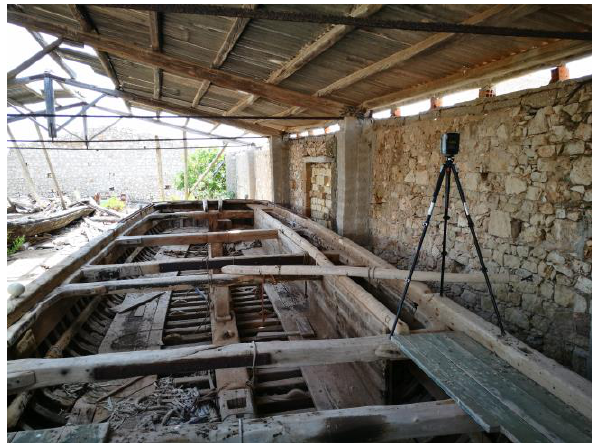
Figure 9. Survey phases of the ‘sciere ’ within the ‘trizzana ’ on Capo Passero Island.